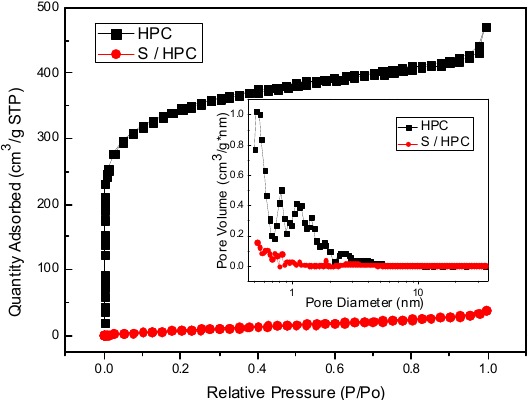
Figure 2. N 2 adsorption-desorption isotherms and pore size distribution of HPC and S/HPC composite.